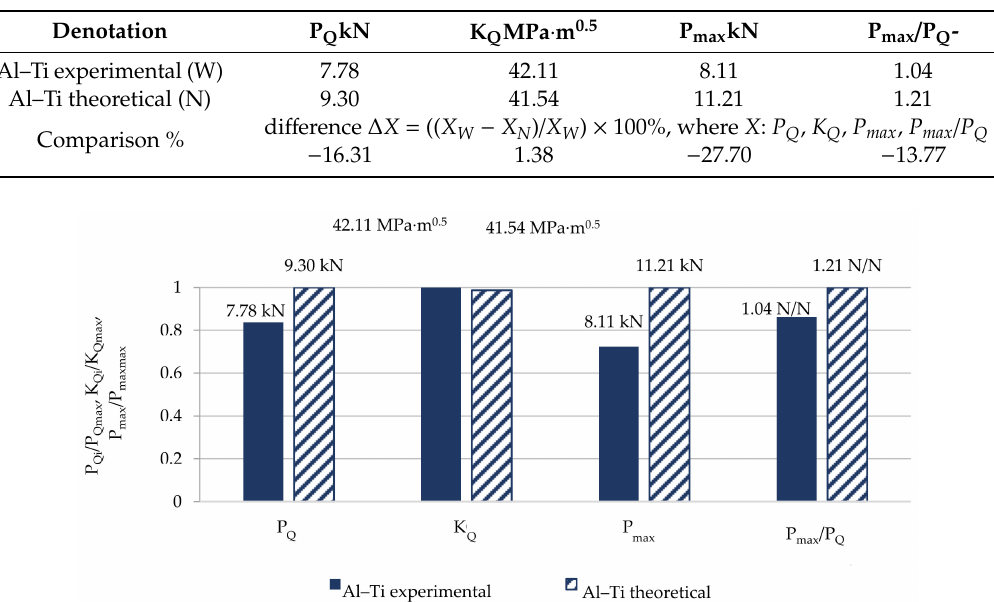
Figure 17. Theoretical and selected experimental curves of load–crack opening obtained from calculations for Al–Ti layered material for cryogenic conditions. Table 8. Comparison of selected mechanical properties obtained experimentally and theoretically for Al–Ti layered material for cryogenic conditions.